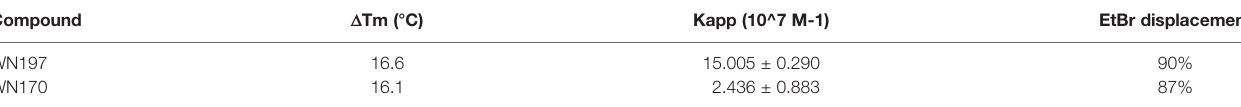
TABLE 3 | Melting curves and fl uorescence measurements were determined for WN197 and WN170.